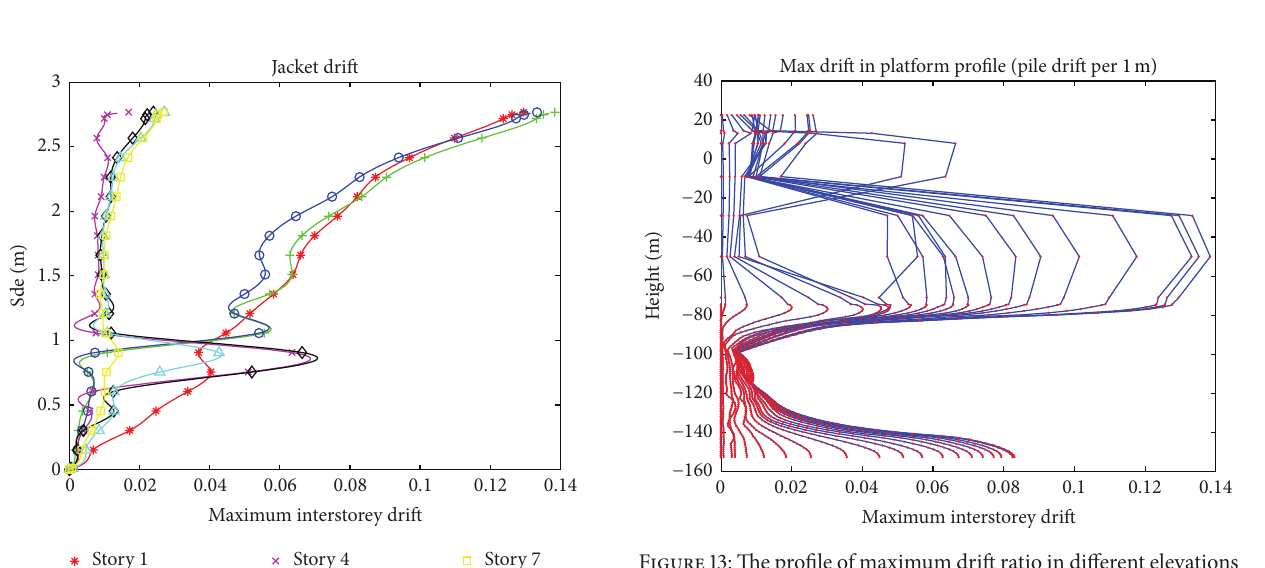
Figure 11: IDA curves of PSP platform subjected to record number 17.